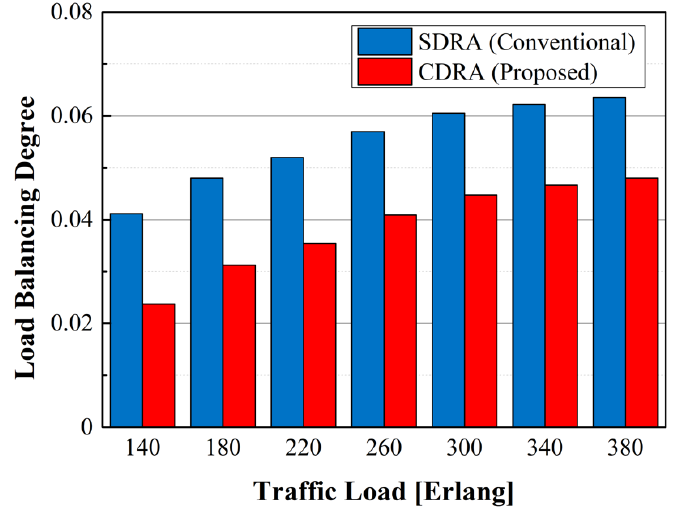
Figure 10. Performance comparison in terms of load balancing degree.